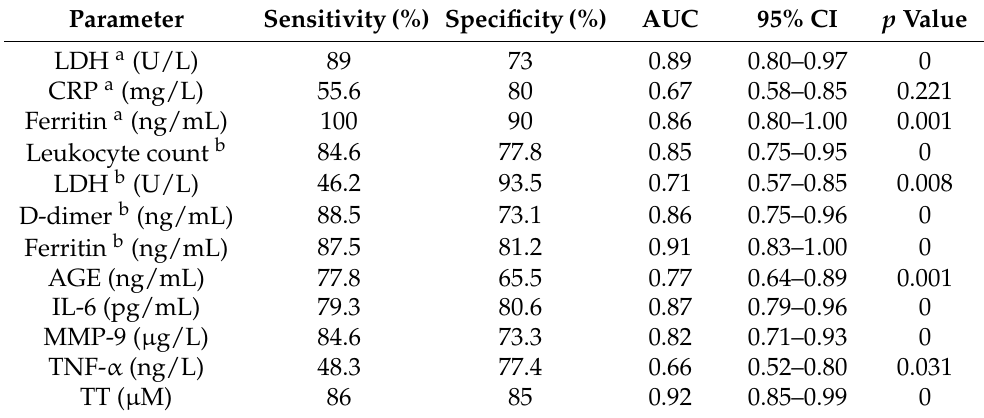
Table 5. Predictive performance for serum markers to distinguish patients who developed confirmed acute respiratory distress syndrome from mild to moderate pneumonia patients.